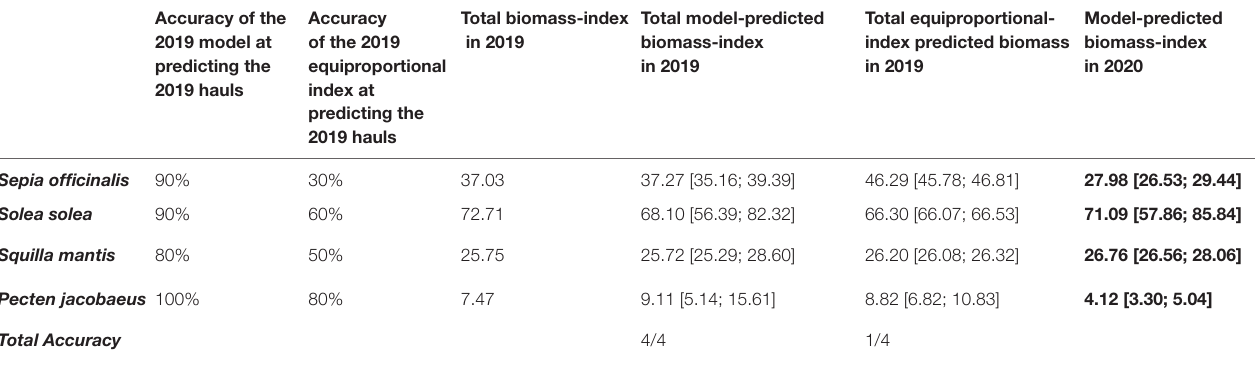
TABLE 3 | Performance of our model with respect to measured 2019 biomass-indexes across the four analysed stocks. Accuracy of the 2019 model